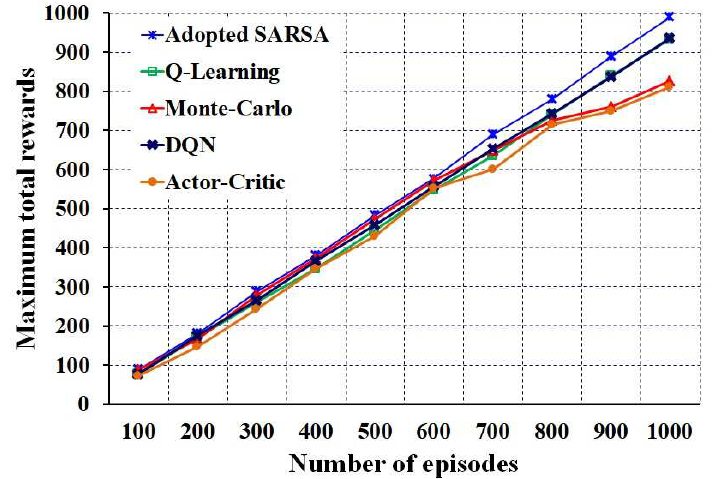
Figure 8. Maximum cumulative reward